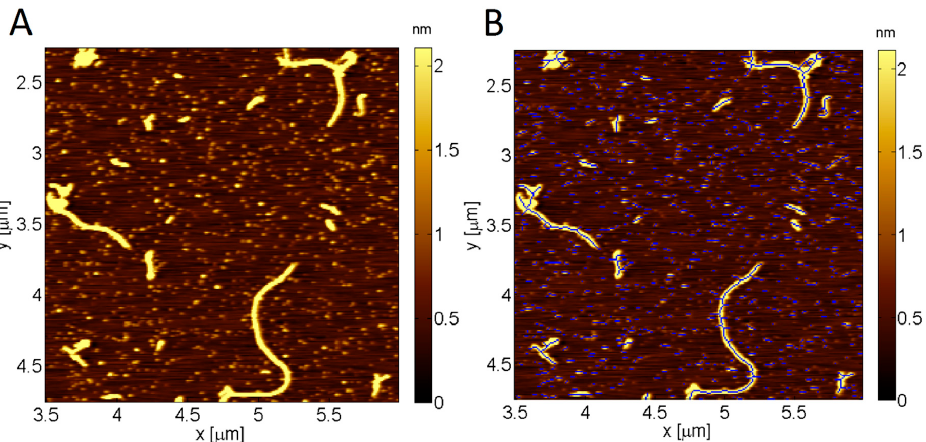
Figure 4. Image analysis using custom MATLAB code to measure the length, height and surface coverage of fibrils. ( A ) AFM topography image of amyloid fibrils and oligomers on a mica surface; and ( B ) custom-developed routine in MATLAB successfully detects and traces the long axis of all fibrils and oligomers, as shown in blue.